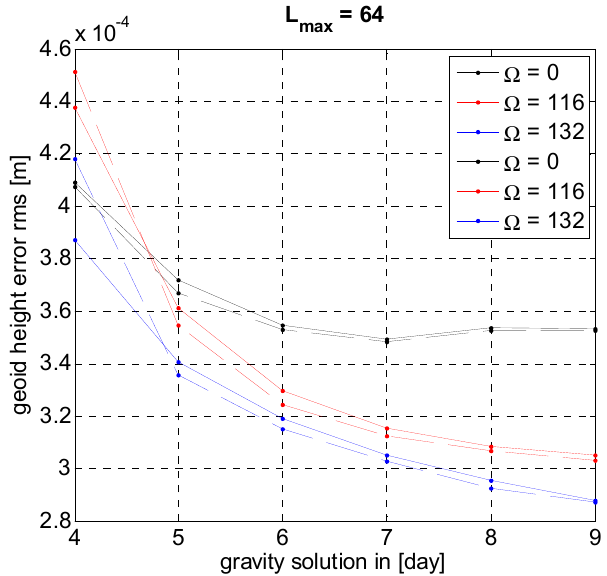
Figure 13. Global error RMS in terms of geoid height for odd (solid line) and even (dashed line) parities (Pendulum scenarios (a) and (b) of the Table 2, respectively) for the gravity solutions up to maximum spherical harmonic degree and order 64. Different colors stand for different Ω .